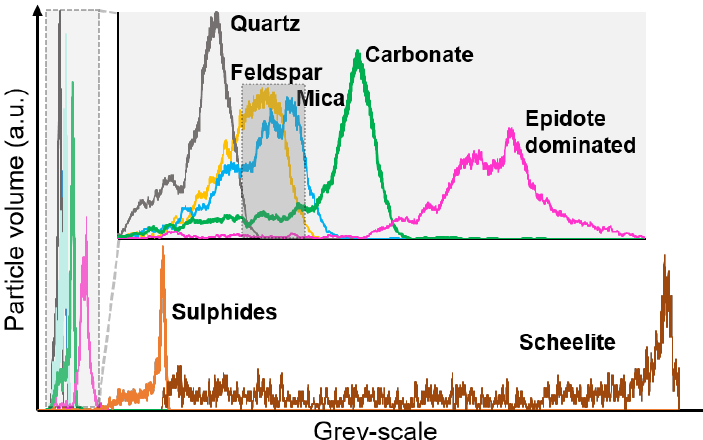
Figure 7. Histogram of individual particles that represent the mineral phases or mineral groups identified by the MLA analysis. Epidote dominated particle has multiple phases as shown in Figure S3. Note the significant overlap between feldspar and mica.